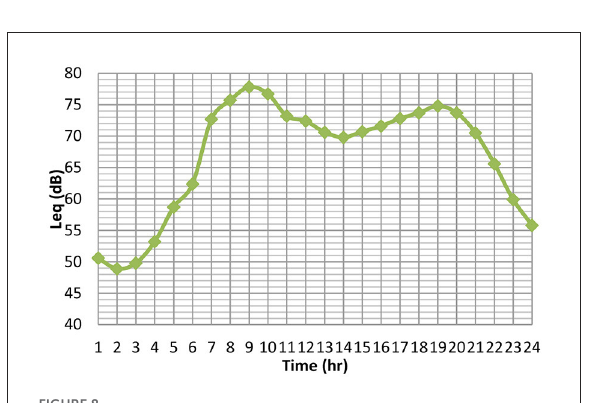
FIGURE8 Variation of hourly average noise level at Connaught Place.